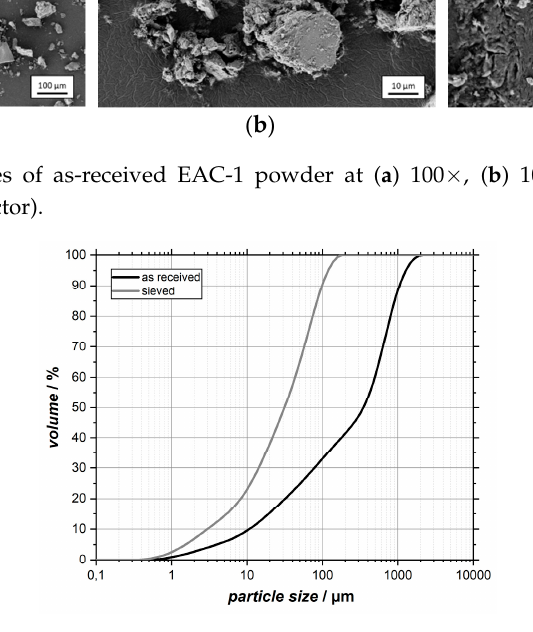
Figure 3. Cumulative particle size distributions of the as-received and the sieved EAC-1 material.